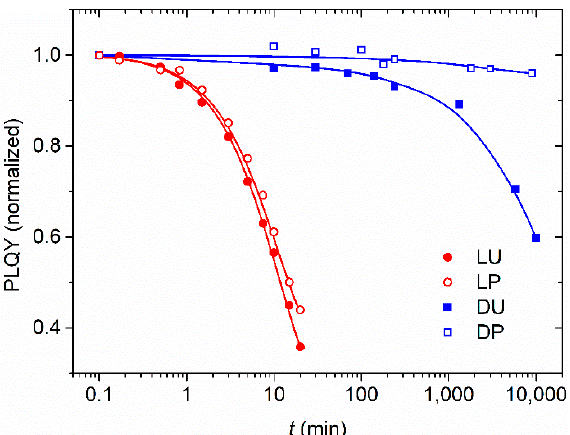
Figure 11. Normalized PLQY of an unprotected 30 wt% TPD doped PS active film stored in the dark (DU, blue full squares) or irradiated under UV pulsed light at 355 nm (LU, red solid circles). Experiments were repeated in samples with a protecting layer of dry-developed DCG in the dark (DP, blue empty squares) and irradiated with UV pulsed light (LP, red empty circles).